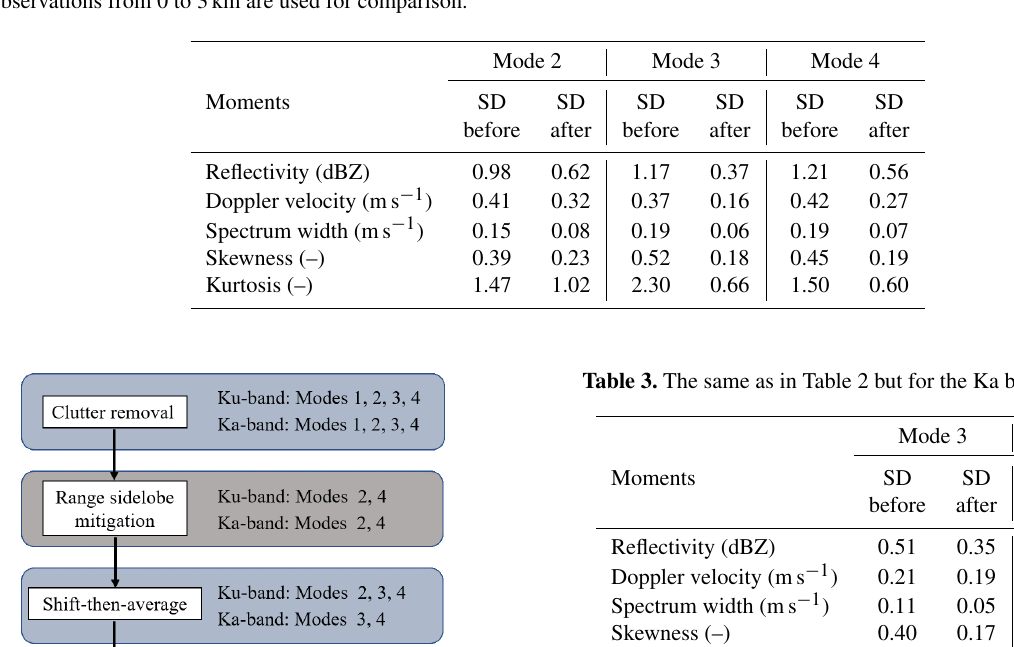
Figure 13. Same as Fig. 12 but for the Ka-band radar. Note that Ka-band radar observations at mode 1 were not used due to the limited Nyquist velocity, while mode 2 data were discarded due to the power loss during coherent integration. Table 2. Standard deviation (SD) for Ku-band spectral moments before and after the declutter approach compared with the reference data. Radar observations from 0 to 3km are used for comparison.